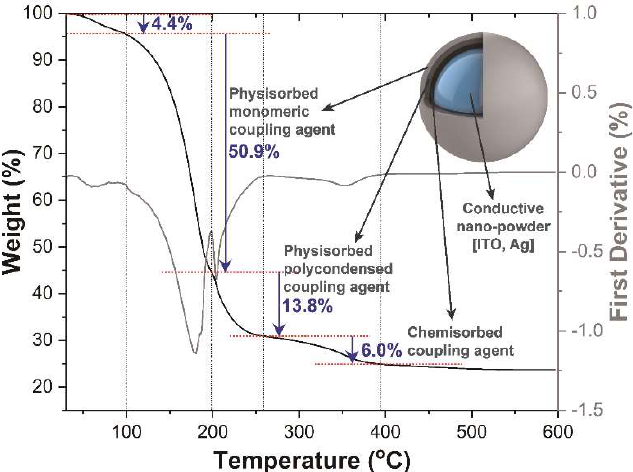
Figure 2. Thermal gravimetric analysis (TGA) and its first derivative curve for KR−44 coupling agent. Inset: schematic diagram of layered coupling agent distribution covering the conductive particle.